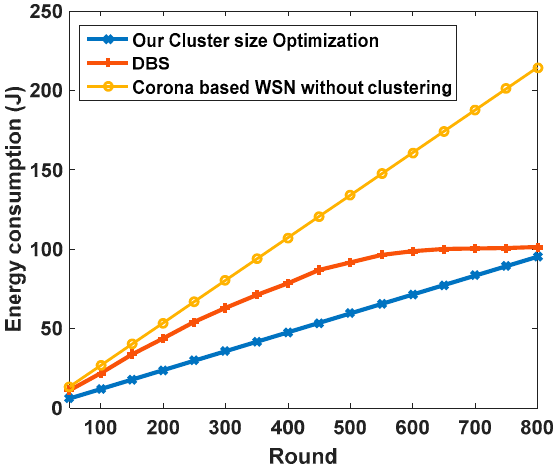
Figure 8. Total energy consumption in our proposed method, DBS and corona-based WSN without applying clustering.